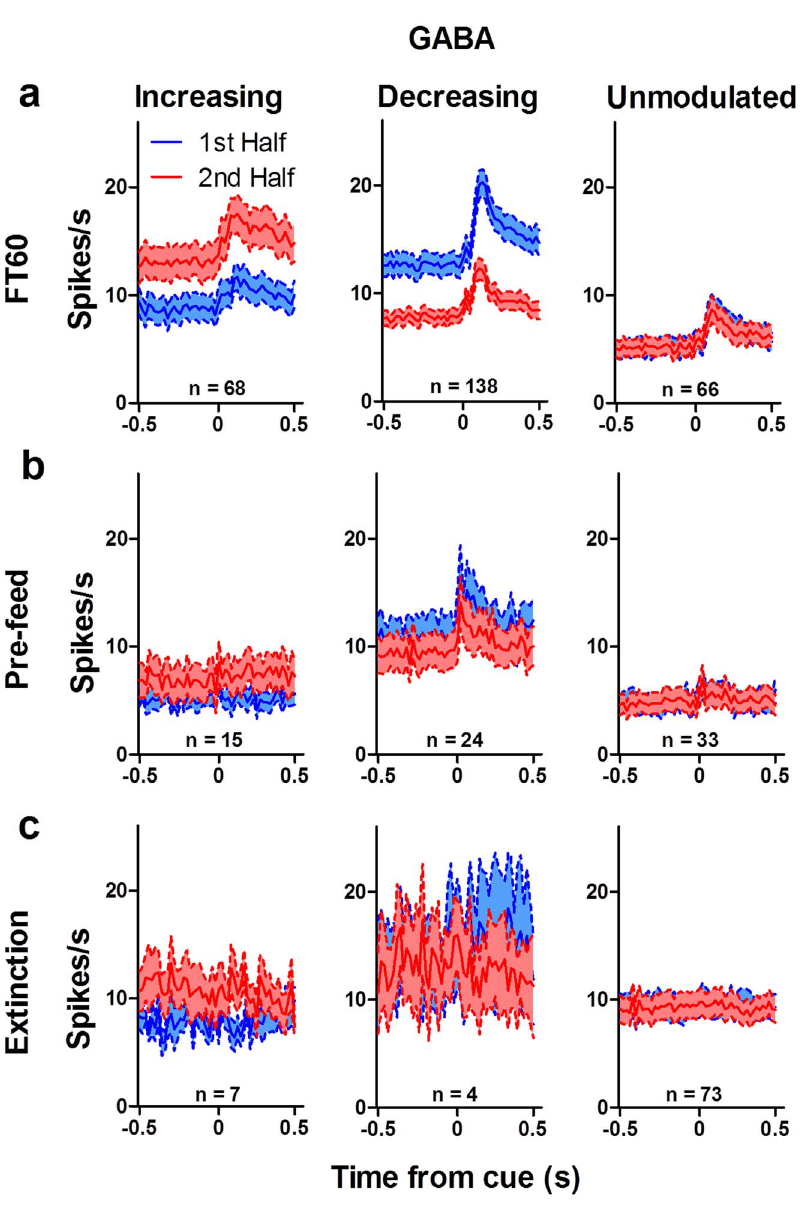
Figure 12. Summary of phasic response in GABA neurons. GABA neurons show the same pattern of modulation as DA neurons. ( a ) The phasic response to the reward cue of increasing GABA neurons ( n =68) was higher for the second half of FT60 sessions than it was for the first half. Decreasing GABA neurons ( n =138) showed the opposite pattern. The phasic response of unmodulated neurons ( n =66) did not change. Modulation of the phasic response was reduced by pre-feeding ( b ; n =15 increasing, 24 decreasing, 33 unmodulated) and eliminated during extinction ( c ; n =7 increasing, 4 decreasing, 73 unmodulated). The phasic response of increasing neurons was nearly abolished following pre-feeding and during extinction, and the phasic response of decreasing neurons was abolished during